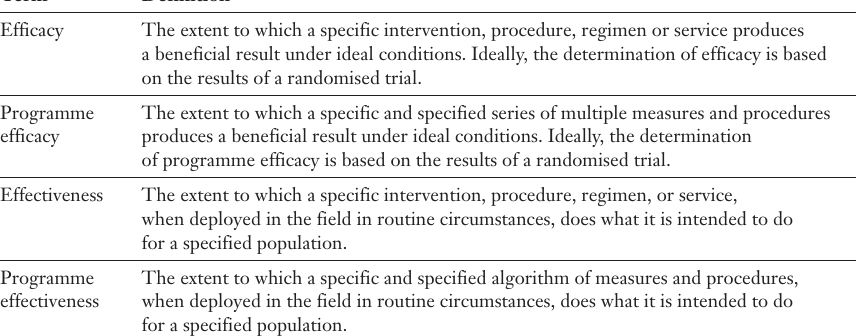
Definitions. Distin- guishing efficacy, programme efficacy and population effec- tiveness (adapted from